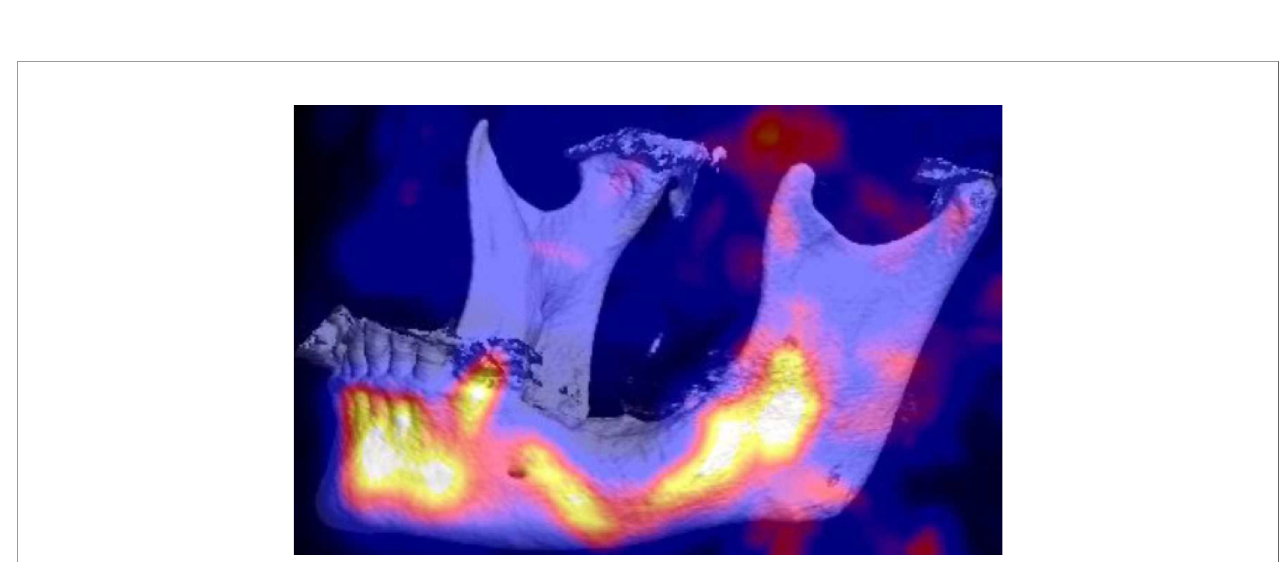
FIGURE 3 | Baseline 18 F- fl uoride PET/CT VRT (Volume Rendering Technique) 3D reconstruction of the jawbone showing substantially increased 18 F- fl uoride uptake in the regions 38 to 47 of the mandible with a focal gap in region